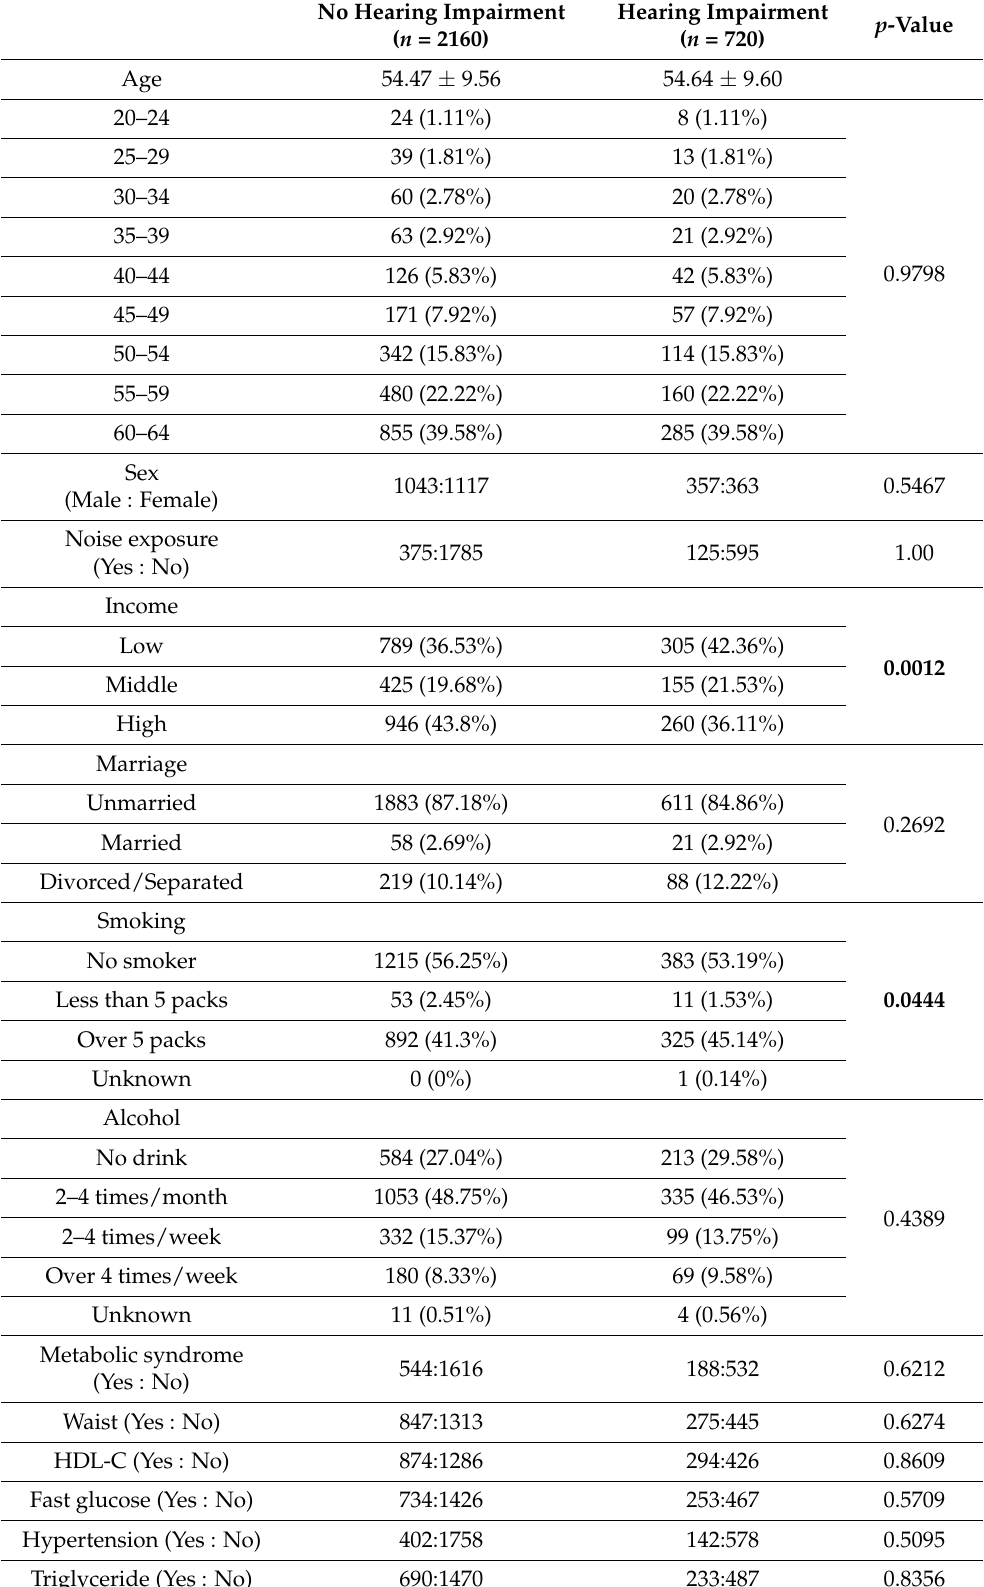
Table 4. Clinical characteristics of subjects (1:3 PS